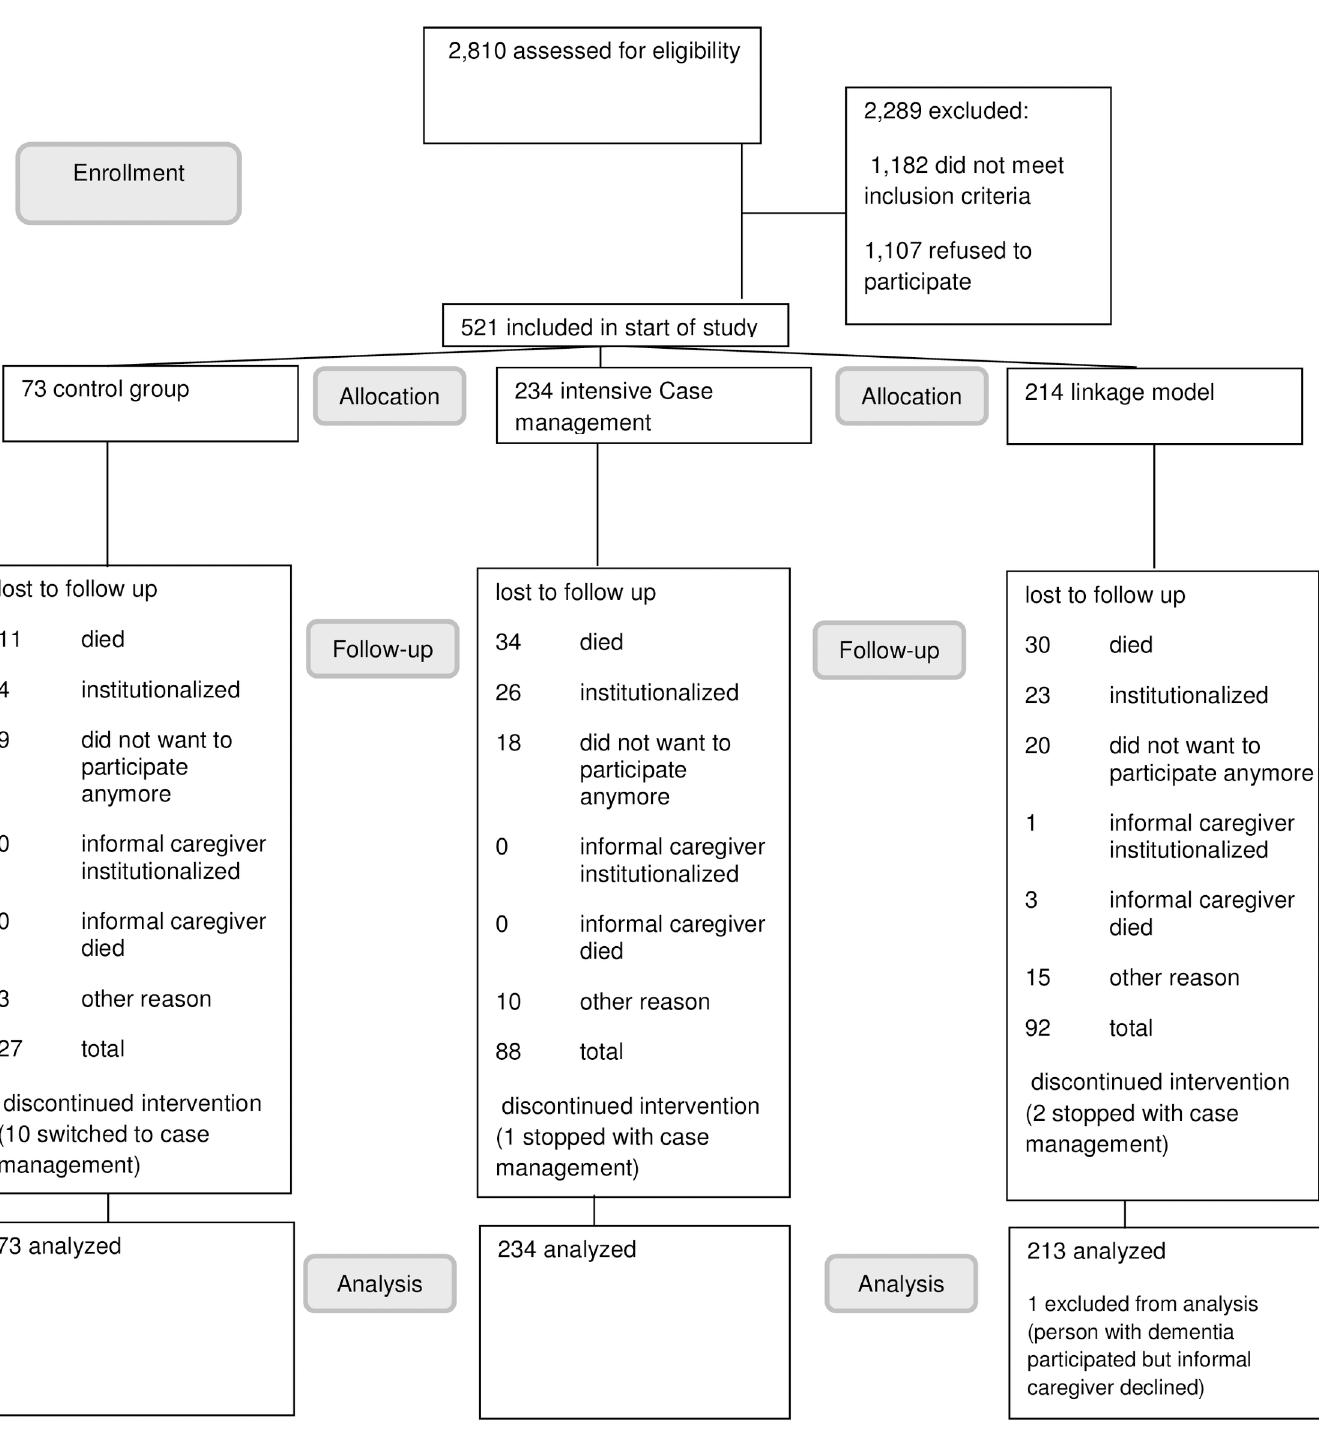
Fig 1. Consort diagram. Recruitment